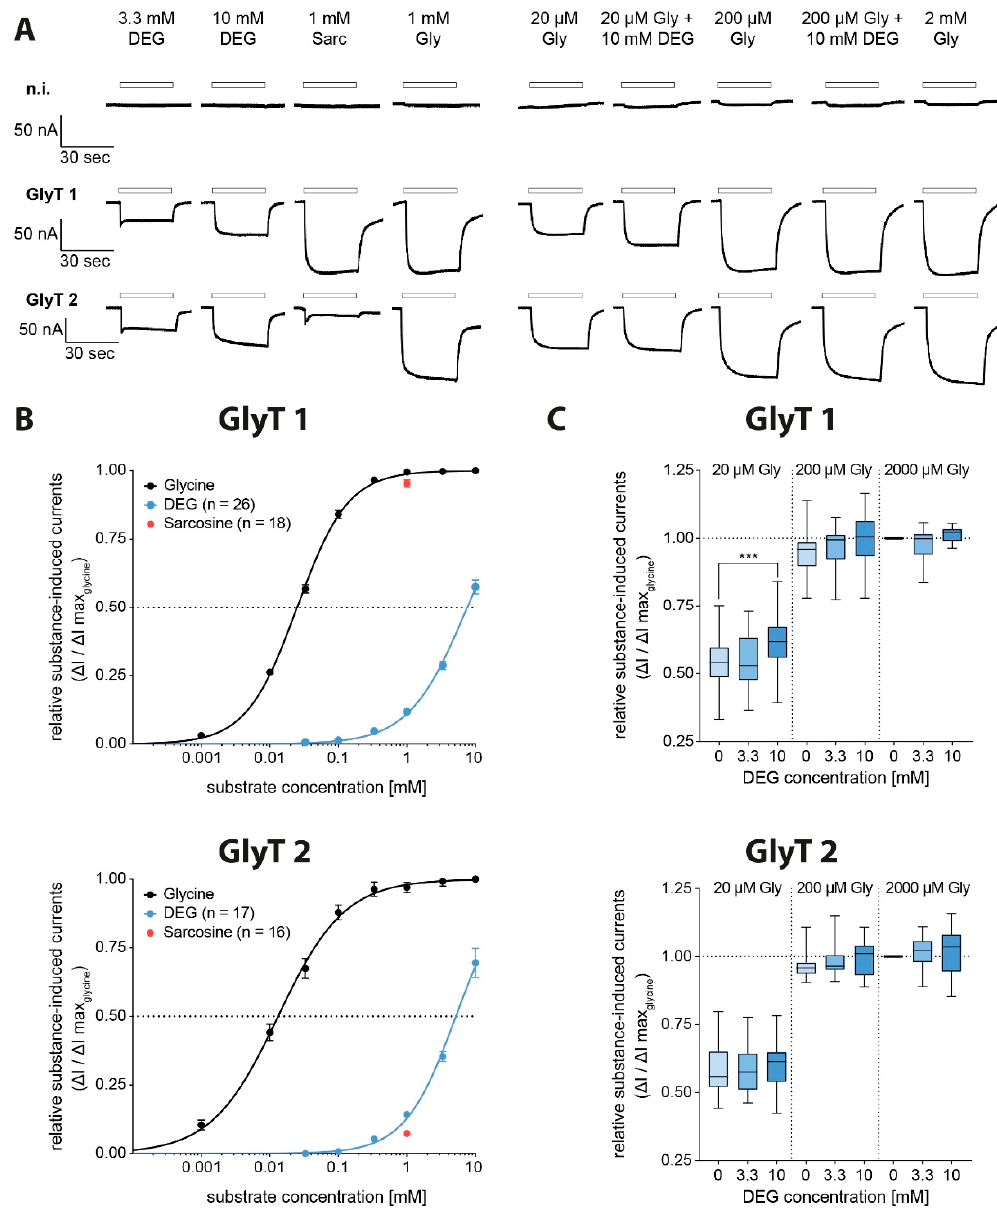
Figure 4. DEG functions as a full agonist at GlyT1 and GlyT2. ( A ) Representative original traces of electrophysiological measurements in Xenopus laevis oocytes expressing GlyT1 and GlyT2 individually after superfusion with DEG solution in increasing substance concentration (100 µ M, 333 µ M, 1 mM, 3.3 mM, 10 mM), sarcosine solution (1 mM) and glycine solution (1 mM) and after superfusion with different glycine solutions (20 µ M, 200 µ M, 2 mM) additionally containing distinct amounts of DEG (0 mM, 3.3 mM, 10 mM) to create co-application conditions. ( B ) Dose–response curves of GlyTs showing DEG and sarcosine-induced currents in relation to the maximum observed current induced by 1 mM glycine in comparison to the construct’s glycine dose–response curve (Figure 2B) (GlyT1: DEG n = 8–26, sarcosine n = 19; GlyT2: DEG n = 17, sarcosine n = 16). ( C ) Relative substance-induced currents of GlyT1 and GlyT2 in relation to the maximum observed current induced by 2 mM glycine + 0 mM DEG solution (GlyT1 n = 13–23; GlyT2 n = 15–31; data shown as boxplots, p < 0.001 (***), one-way ANOVA with Bonferroni post-hoc correction).